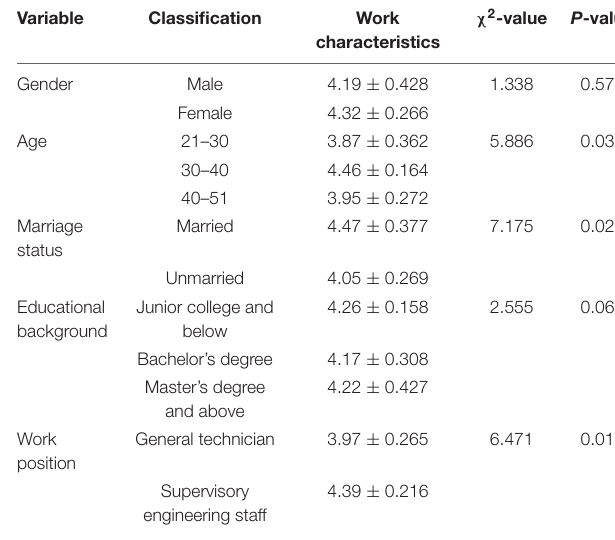
TABLE 3 | Differences in stress values of work characteristics under various demographic